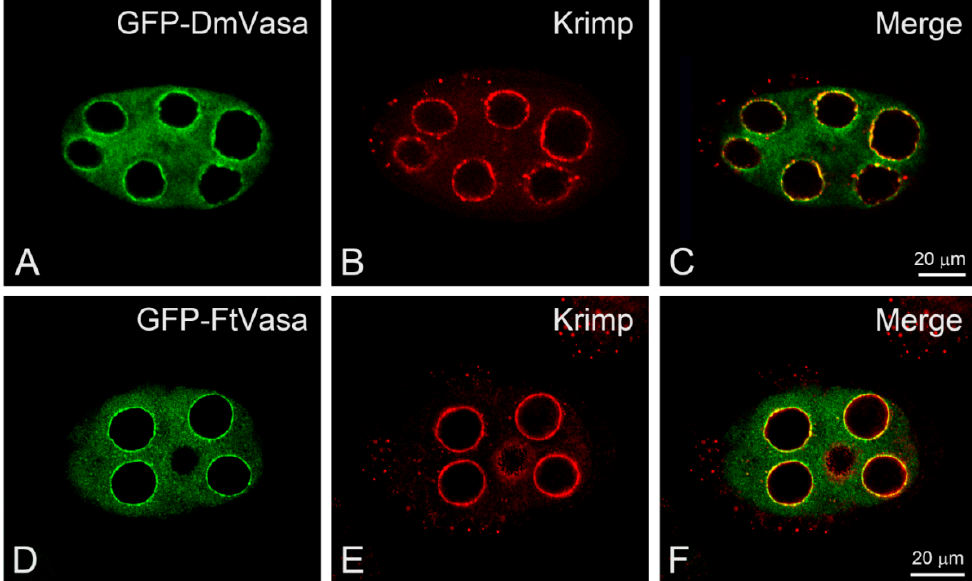
Figure 8. Localization of F. taiwana Vasa to the perinuclear nuage in Drosophila nurse cells. ( A – F ) Confocal micrographs showing the nurse cells of Drosophila egg chambers at stage 6. ( A – C ) ( A ) GFP-tagged Drosophila Vasa (GFP–DmVasa, green) is enriched in the nuclear membrane of nurse cells and colocalized with ( B ) nuage marker Krimper (Krimp, red). ( C ) Merged image. ( D – F ) ( D ) GFP-tagged F. taiwana Vasa (GFP–FtVasa, green) is colocalized with ( E ) Krimper (Krimp, red) in the nuage. ( F ) Merged image.